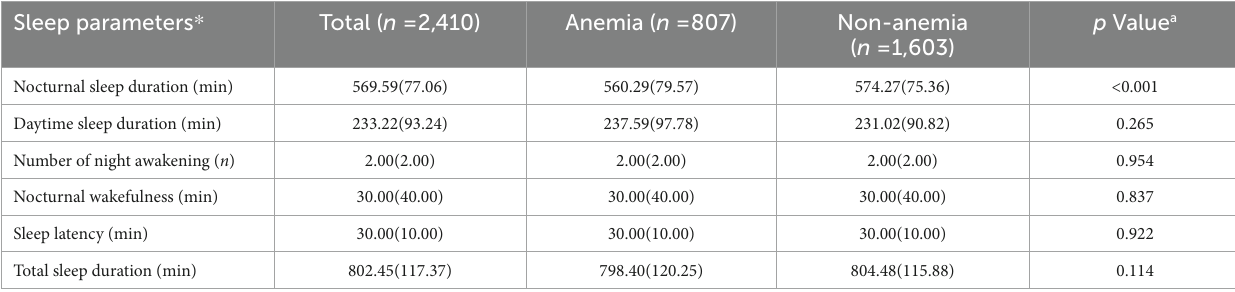
TABLE 2 Comparison of sleep parameters between infants born to mothers with anemia vs. mothers without anemia ( n = 2,410). Sleep parameters